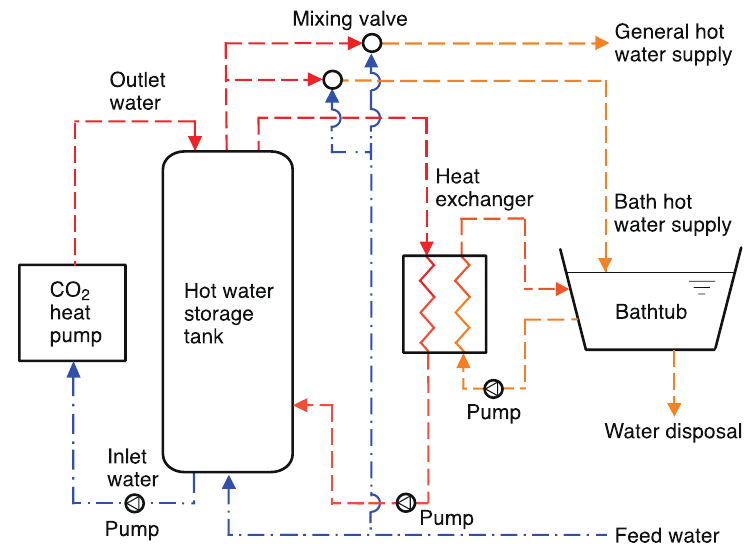
Figure 1. Configuration of multi-functional CO 2 heat pump water heating system.